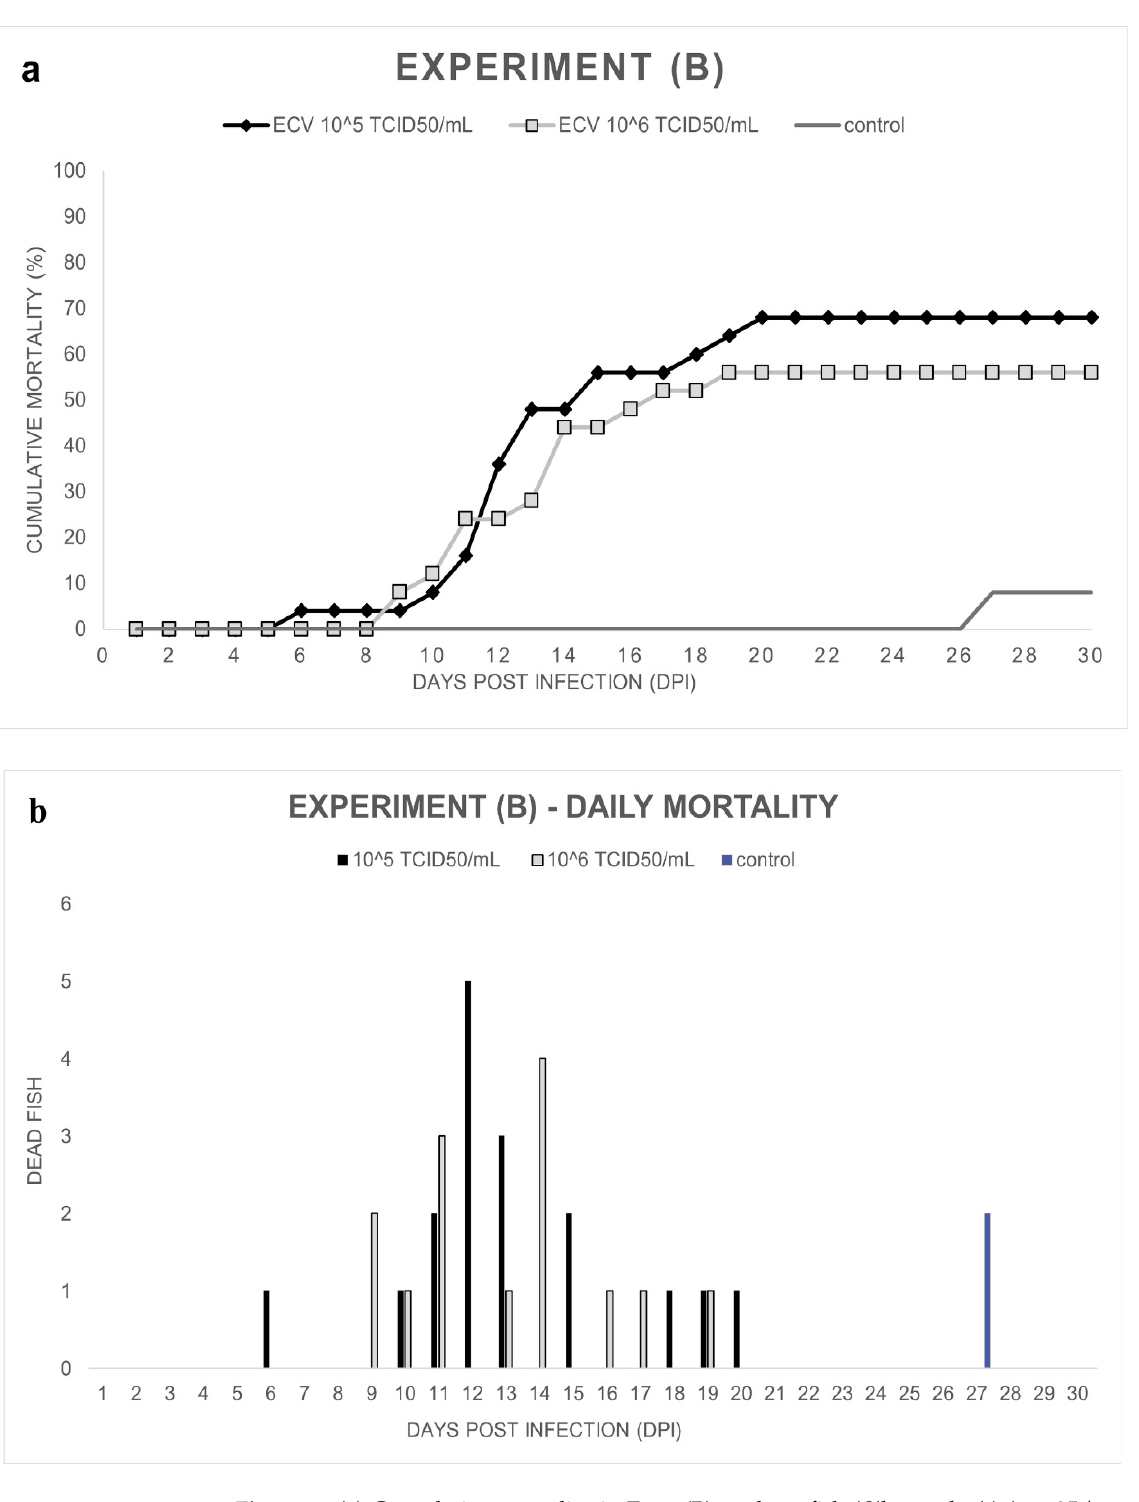
Figure 2. ( a ) Cumulative mortality in Exp. (B), wels catfish ( Silurus glanis ) ( n = 25/group) were infected at 10 weeks of age by bath with ECV at 21 ± 0.5 °C for 1 h. Mortality was recorded from 0 to 30 dpi, including the control group. ( b ) Daily mortality in Exp. (B) shows the number of dead fish per day.